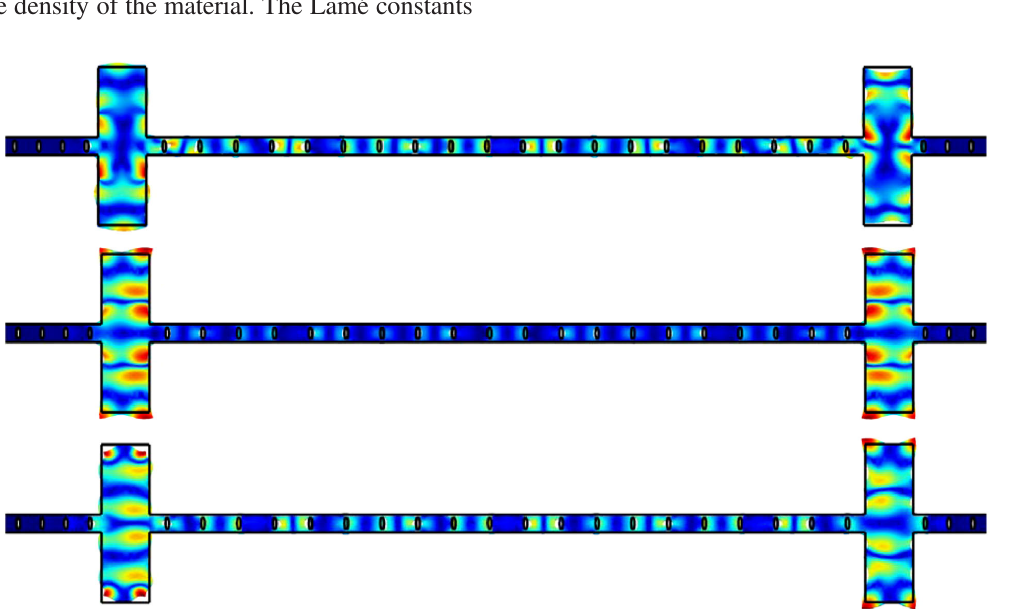
FIG. 11. Displacement patterns of three normal modes in a closed mechanical subsystem. The parameters used are the same as in Fig. 3. The frequencies are (1.6737, 1.6791, 1.6826) GHz from top to bottom. The triplet arises from the coupling between the fifth- order compression modes in the two neighboring plate resonators and the nearly resonant waveguide mode. The array of holes in the waveguide has a period of 6 μ